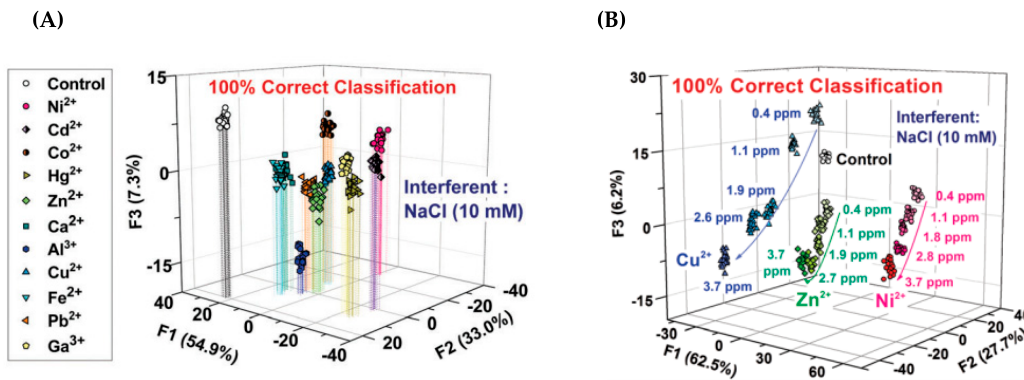
Figure 17. ( A ) Linear discriminant analysis (LDA) score plots for the response of the sensor array to 11 analytes (and control) in a HEPES buffer (50 mM) solution, with sodium chloride (10 mM). The [metal ion] = 10 mM. 20 repetitions were measured for each analyte. ( B ) The cross-validation routine shows 100% correct classification LDA results of the semi-quantitative assay, toward three different metal ions (Cu 2+ ,Zn 2+ and Ni 2+ ); concentration range of 0–3.7 ppm.%. Adapted from [218] with permission from The Royal Society of Chemistry.